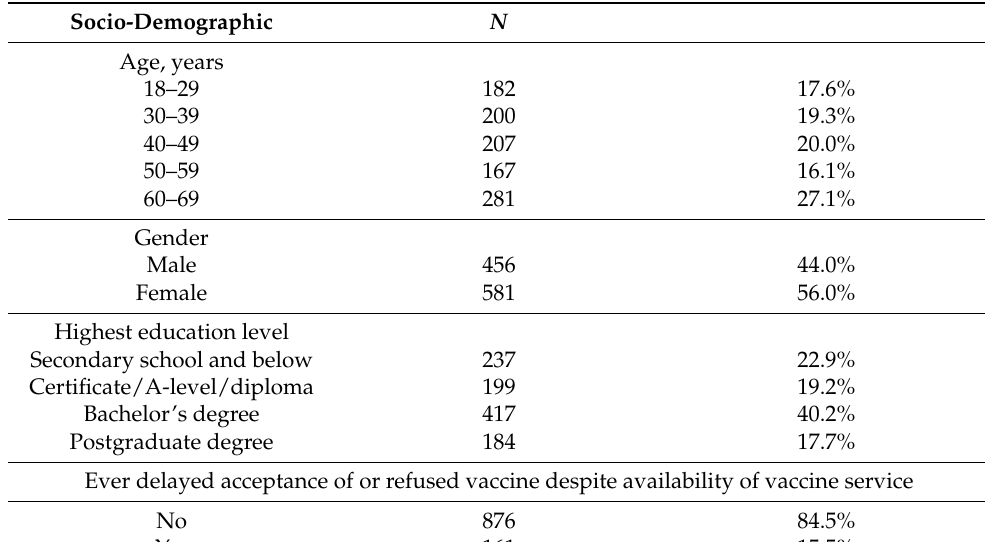
Table 1. The descriptive demographics of the participants in Japan ( N =